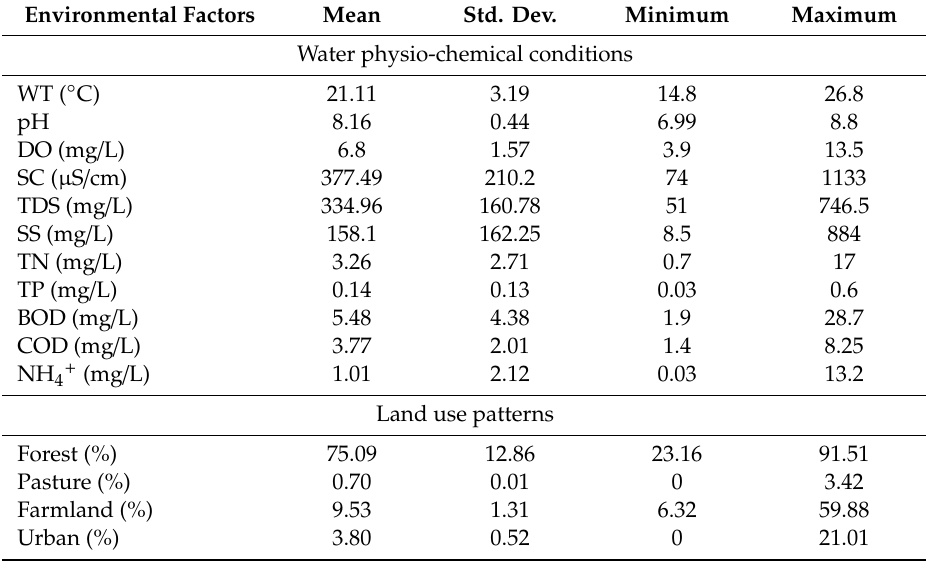
Table A1. Water quality parameters and land use patterns in the Taizi River catchment ( n =